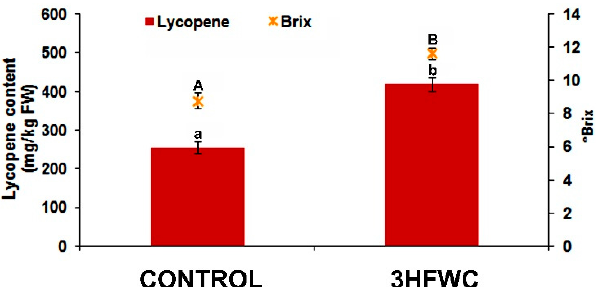
Figure 9. The lycopene content and BRIX° in fruits of control and 3HFWC nanosubstance-exposed cherry tomato plants. The presented data are mean value ± standard error. Different letters indicate statistically significant differences according to LSD test ( p ≤ 0.05).